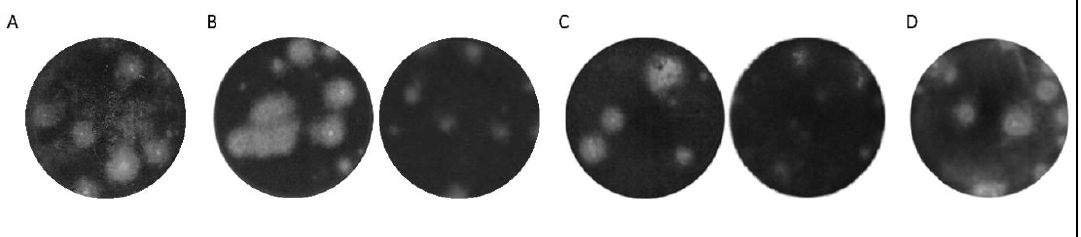
Figure 2. Plaque size and morphology in mammalian porcine kidney (PS) cells during serial passaging of tick-borne encephalitis virus variants in PS and IRE/CTVM19 tick cells. ( A ) Plaque size of the parental strain 0P. ( B ) Difference in plaque size between 30 PS (left) and 30 IRE (right). ( C ) Difference in plaque size between 40 PS (left) and 40 IRE (right). ( D ) Plaque samples of LT IRE after continuous propagation for a month in the IRE/CTVM19 cell line. Well diameter captured in the photographs is 16 mm.